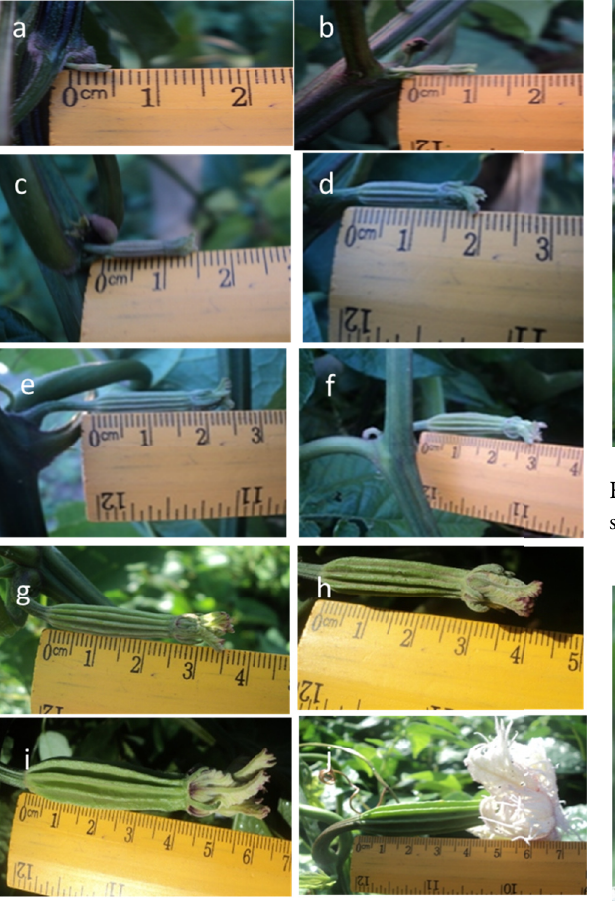
pment of Fig. 3. Structure 3. Structure of fluted pumpkin